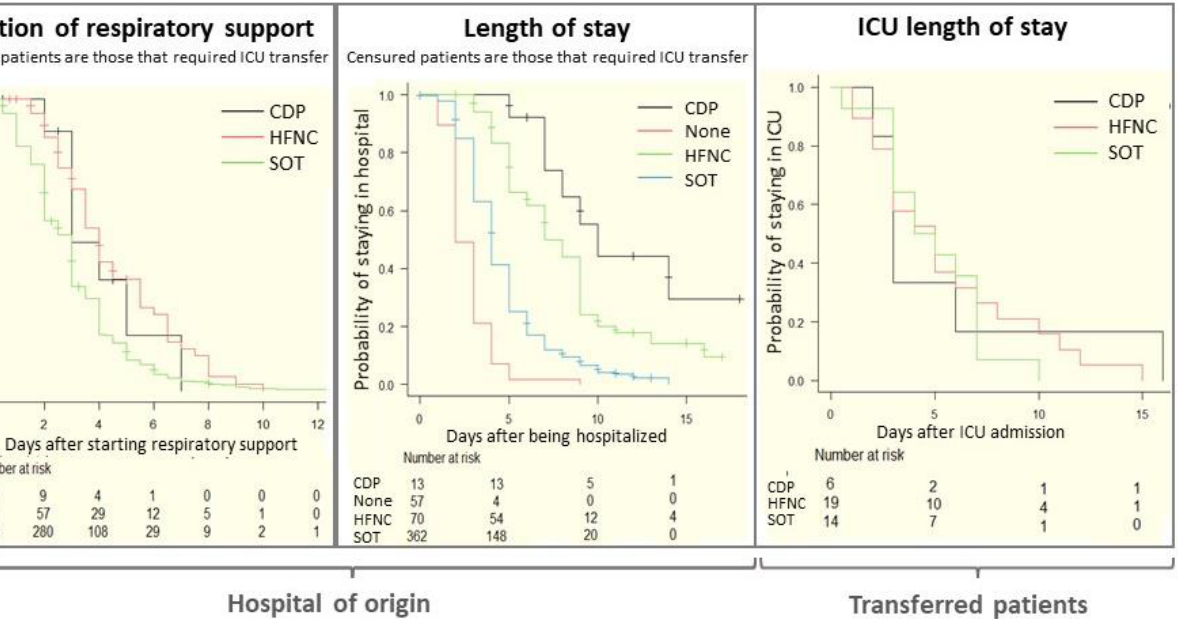
Figure 3. Kaplan–Meier graphics by groups for duration of respiratory support and hospital length of stay in our hospital (hospital of origin) and ICU stay for those who were transferred.